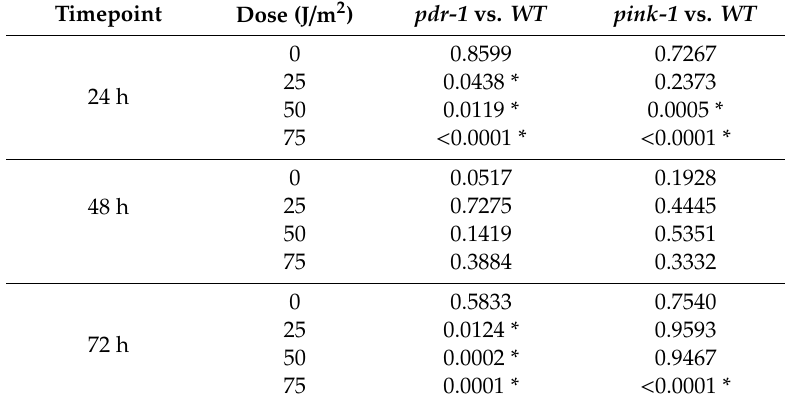
Table 3. p -values (Fisher’s exact test) for strain comparisons ( pink-1 and pdr-1 vs. WT) after UVC exposure in L4 C. elegans